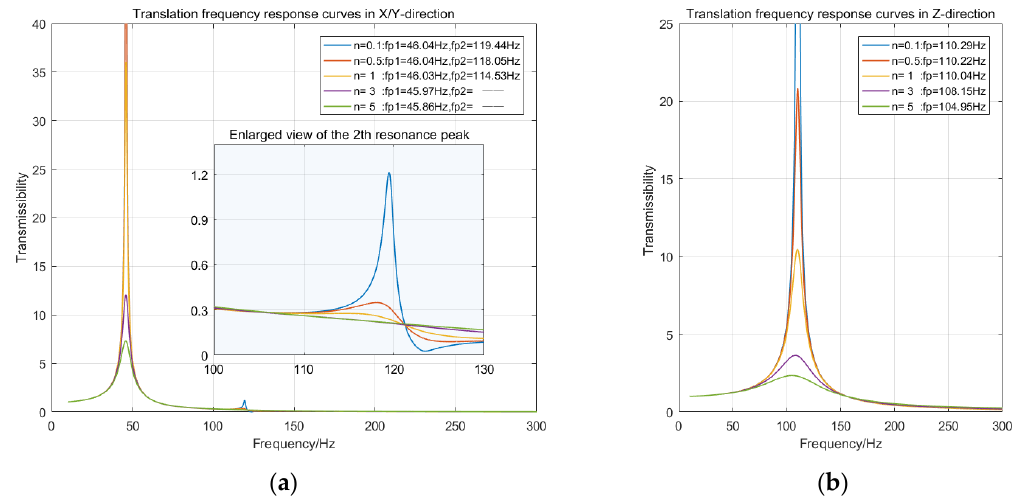
Figure 10. Stewart platform frequency response curves with different damping: ( a ) horizontal X / Y -direction frequency response curves; ( b ) vertical Z -direction frequency response curves.